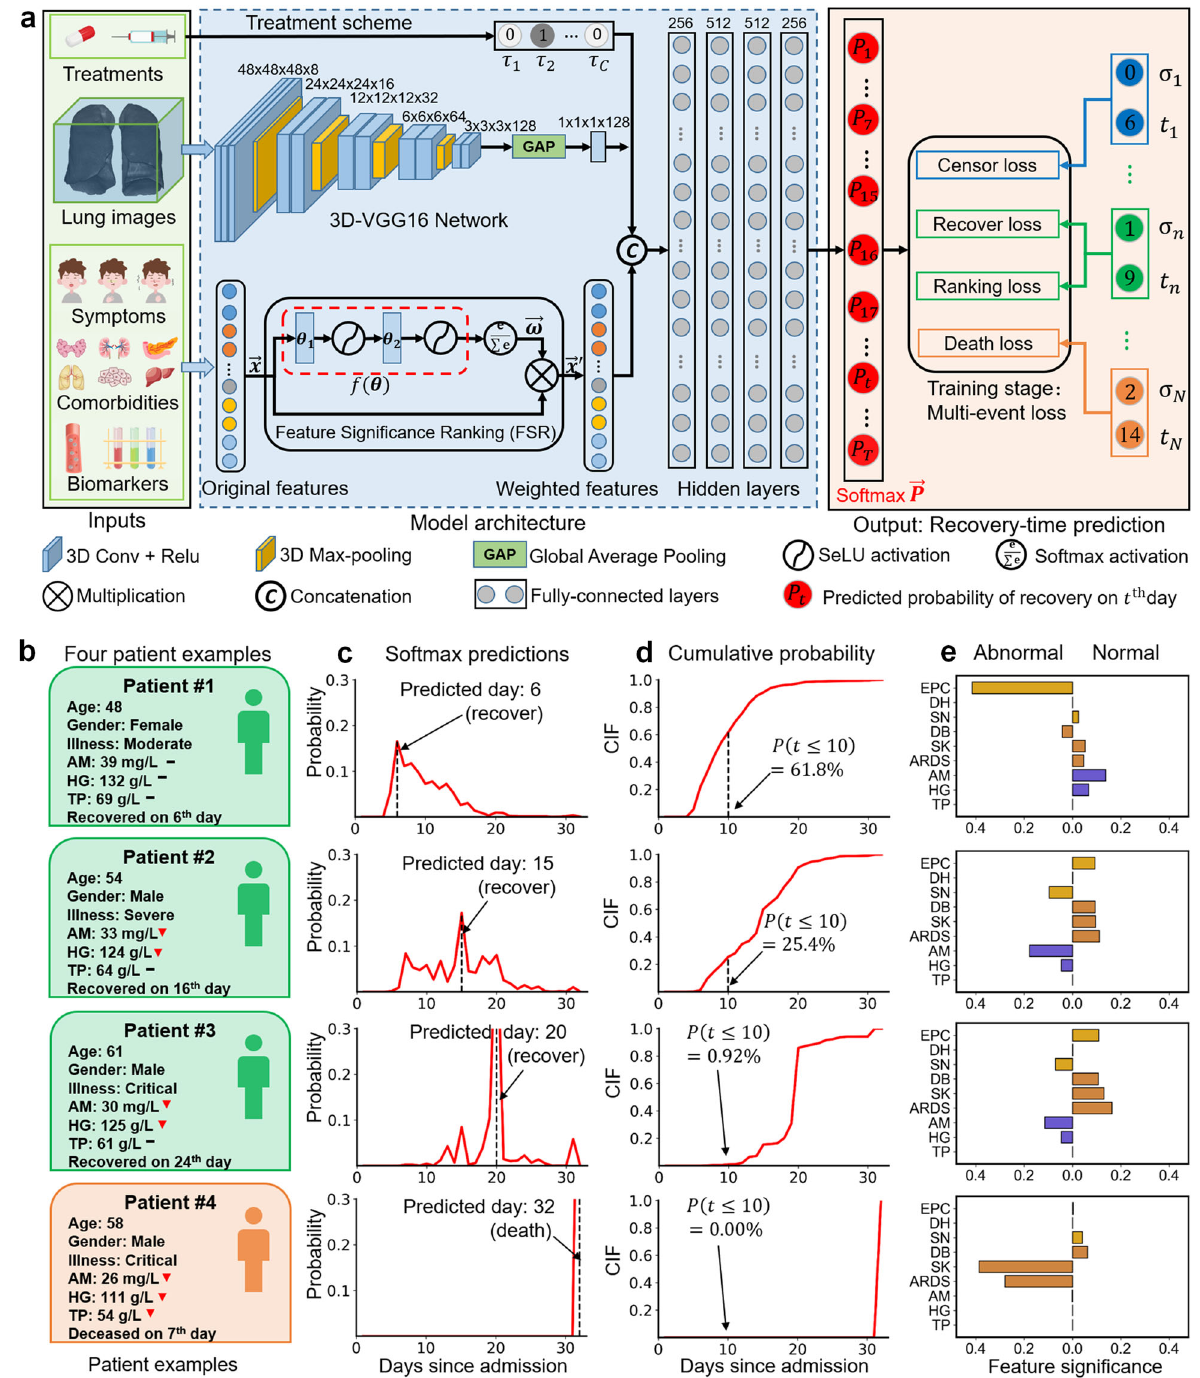
Fig. 3 Framework architecture and predictions of four patient examples. a The treatment schemes, lung CT images, and clinical features of the patients are fed to the framework for recovery-time prediction. The FSR subnetwork is designed to learn the signi fi cance of each clinical feature that contributes to the predictions. A multi-event loss is designed to train the model using data from patients with different outcomes. ! b The information of the patients. c The softmax outputs (i.e., P in a ) of the four patients. The days a patient needs to recover can be estimated by the day with the maximum probability. d The cumulative probability of the softmax outputs, which can be used to assess the risk of patients. e The top nine clinical features that are signi fi cant for the decision made by the model ( EPC expectoration, DH diarrhea, SN soreness, DB diabetes, SK shock, ARDS acute respiratory distress syndrome, AM albumin, HG hemoglobin, TP total outcome type as follows: censored data | σ n = 0, recovery| σ n = 1, used for the patient. I n is an image matrix of the CT scan. x ! n refers to a vector consisting of the 46 clinical feature values. s n is an and death| σ n = 2. t n is the day on which the outcome occurred. indicator of the severity-level as follows: mild| s n = 0, moderate| s n = 1, severe| s n = 2, and critical| s n = 3. σ n is an indicator of the